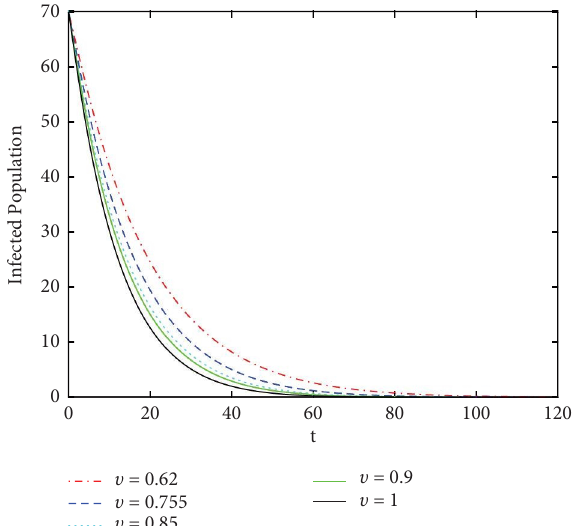
Figure 18: Te dynamics of vaccinated human population for various fractal orders π and for fractional order υ � 0 . 5.